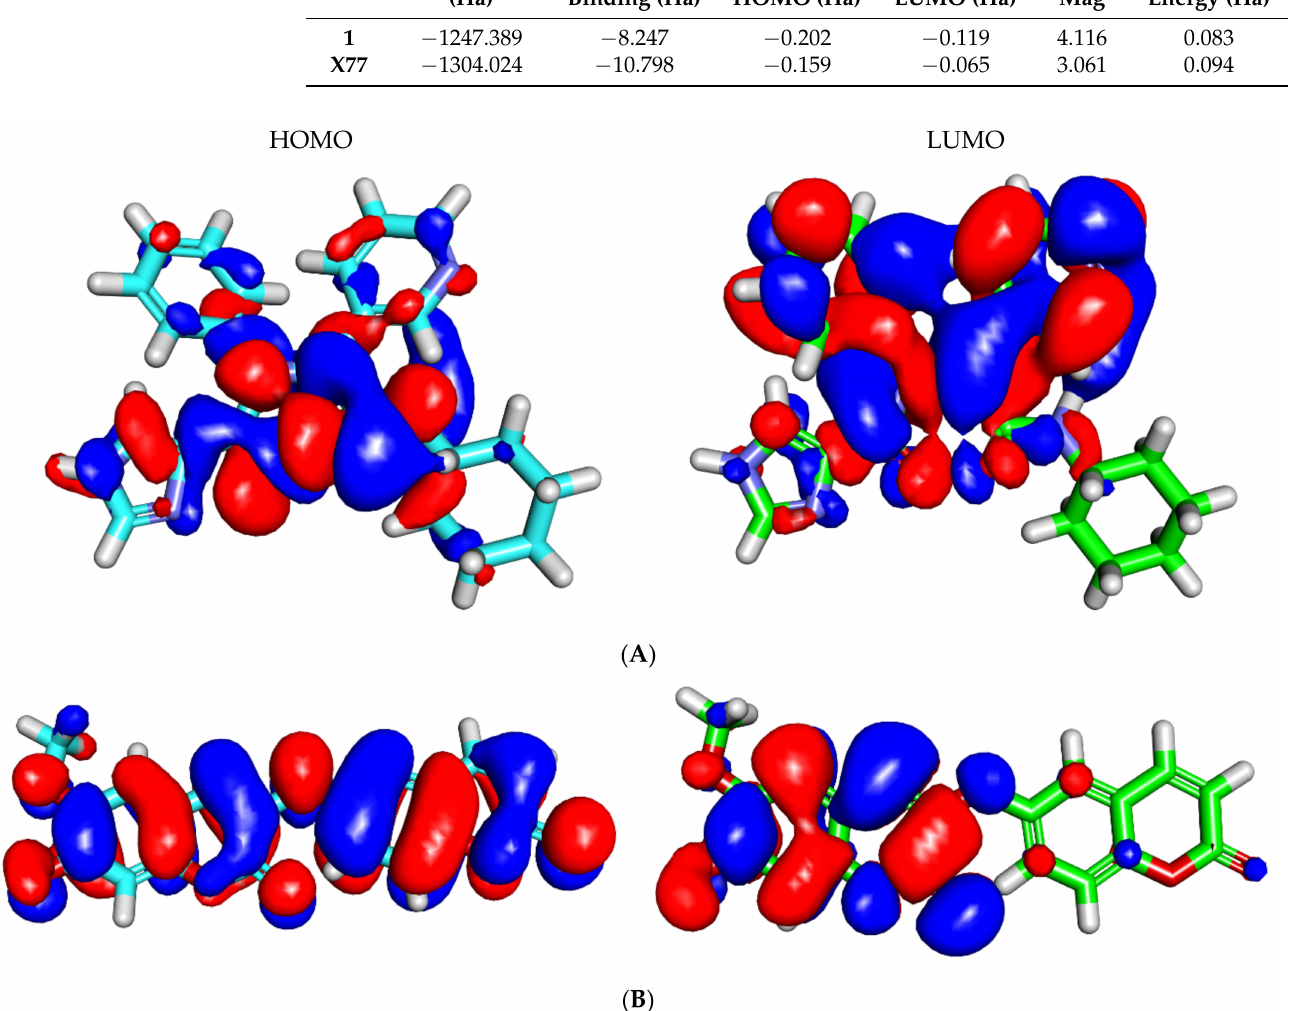
Figure 7. Spatial distributions of molecular orbitals for ( A ) jusan coumarin and ( B ) X77